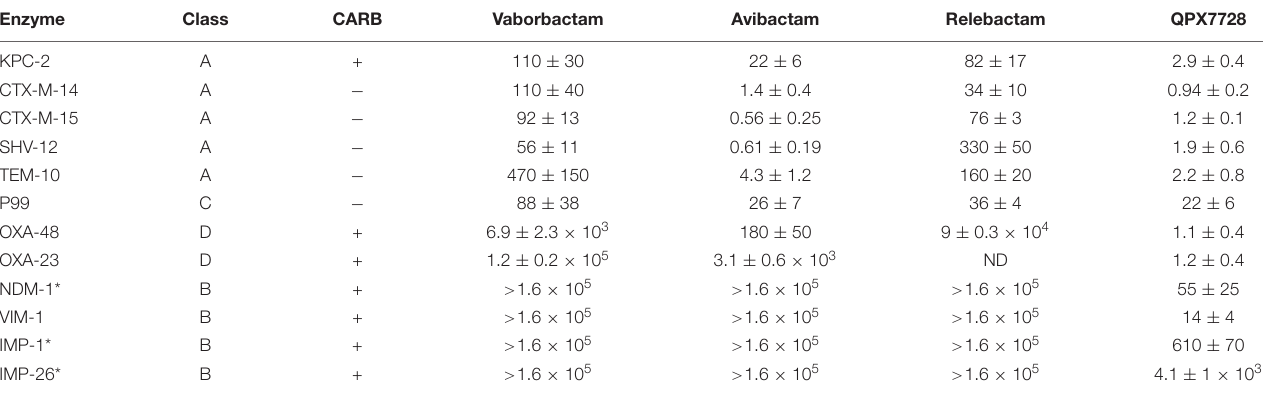
TABLE 1 | Potency (IC 50 , nM) of β -lactamases inhibition by QPX7728 compared to other